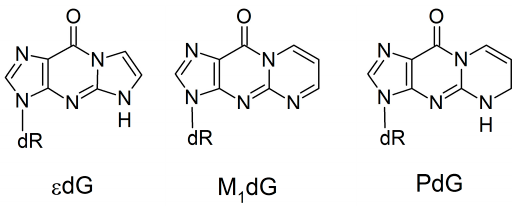
Figure 9. Damaged DNA bases with extended ring systems that lack Watson–Crick hydrogen bonding.